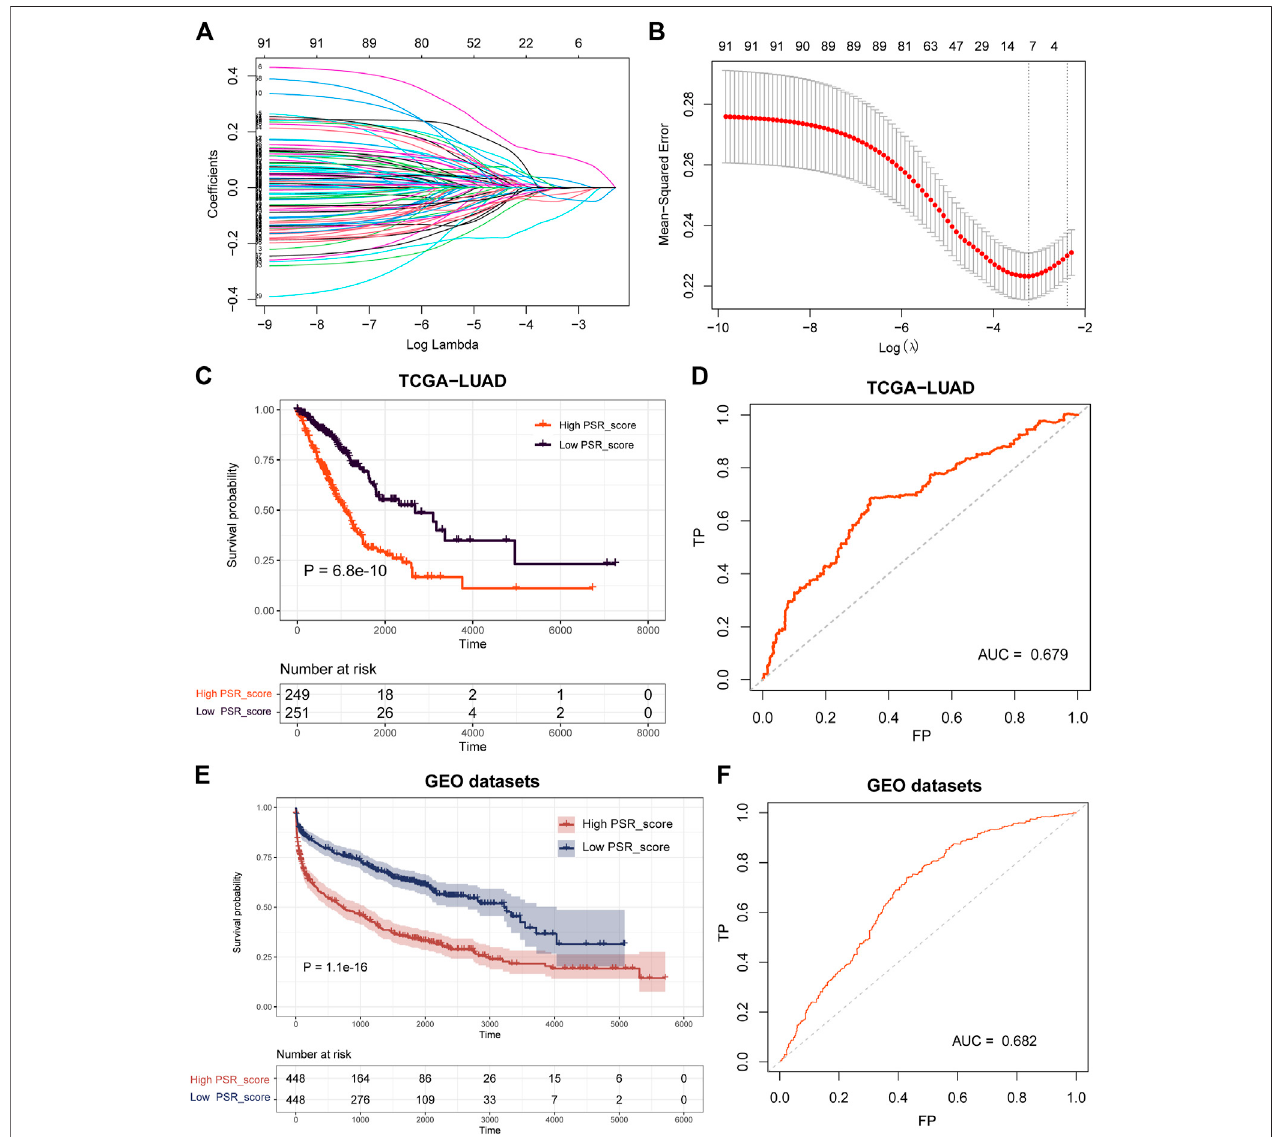
FIGURE 5 | Construction and validation of the prognostic PSR_score by LASSO and COX regression analysis. (A) LASSO coef fi cient pro fi les of 91 blue co- expression module genes. (B) Cross-validation for tuning parameter selection in the LASSO model. (C – D) Log-rank test was employed to assess the difference in OS between high and low PSR_score samples in TCGA cohorts and ROC curve of the prognostic model. (E – F) Log-rank test was utilized to assess the difference in OS between high and low PSR_score samples in the integrated lung cancer cohorts and ROC curve of the prognostic model.